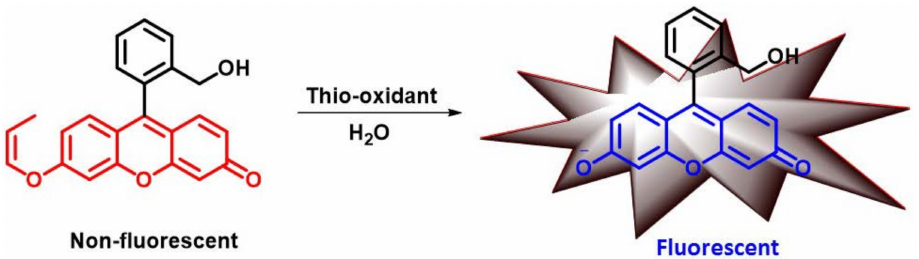
Figure 13. Non-fluorescent DOM upon reacting with a thio-based mercury compound in the presence of an oxidant becomes a highly fluorescent system. Reproduced with permission from [35] by American Chemical Society.